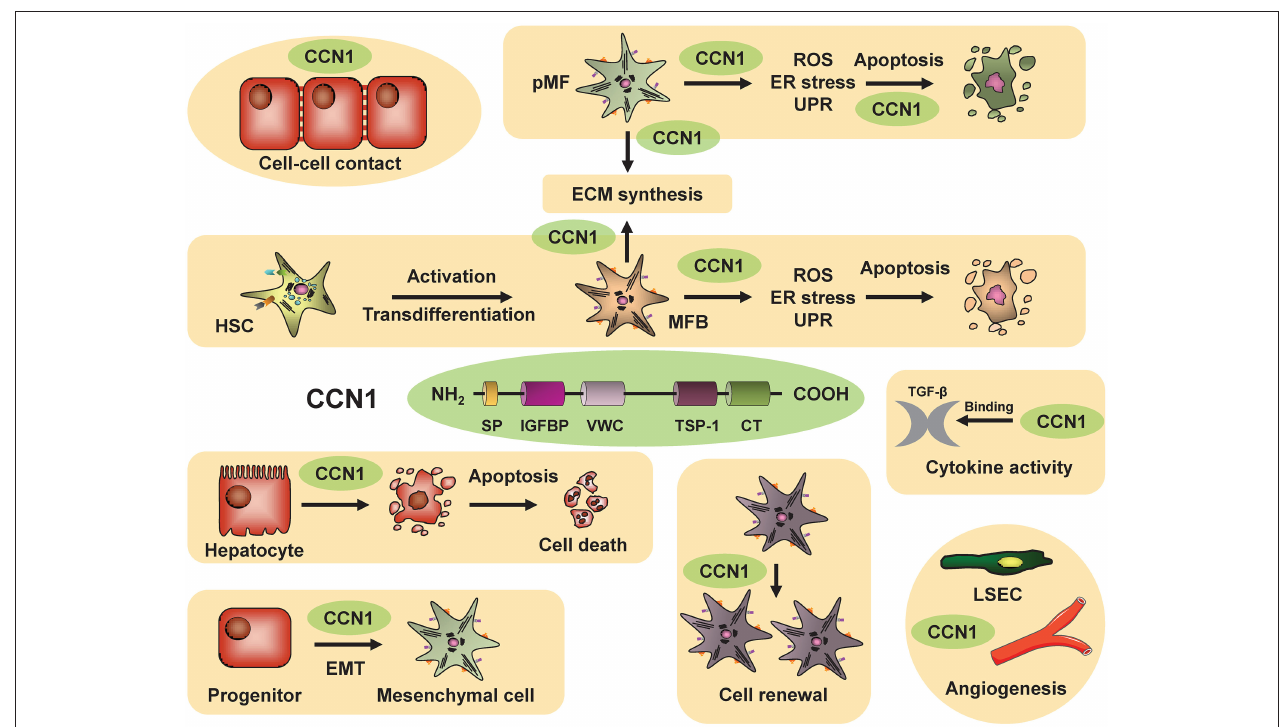
FIGURE 10 | CCN1 in liver homeostasis and disease. CCN1 consists of a secretory signal (SP), an insulin-like growth factor-binding protein domain (IGFBP), a von Willebrand type C domain (VWC), a thrombospondin-1 domain (TSP-1), and a cysteine knot (CT). The biological activities of CCN proteins manifest during liver injury. They stimulate the activation and transdifferentiation of hepatic stellate cells (HSC) to matrix-producing myofibroblasts (MFB), modulate cytokine activity, regulate apoptosis/necrosis, and fine-tune mechanisms involved in control of cell-cell contacts, cell renewal, epithelial-to-mesenchymal transition (EMT), and (neo-)angiogenesis. Large quantities induce endoplasmic reticulum stress and unfolded protein response. Moreover, they can bind cytokines such as TGF- β , thereby modulating their activities and